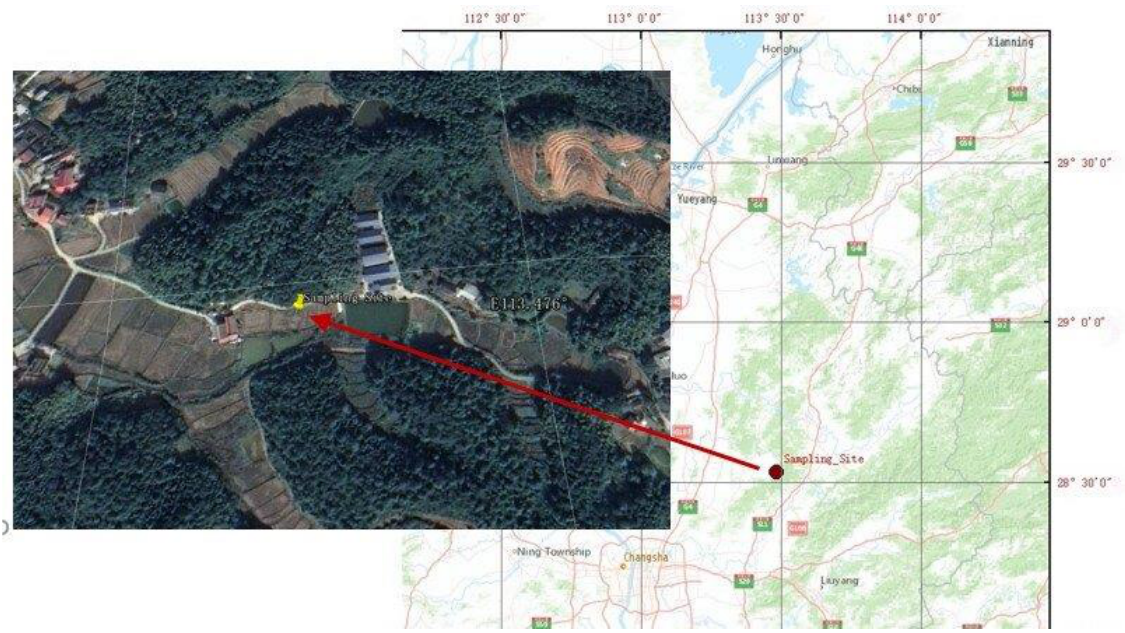
Figure 1. location of the sampling point. Figure 1. Location of the sampling